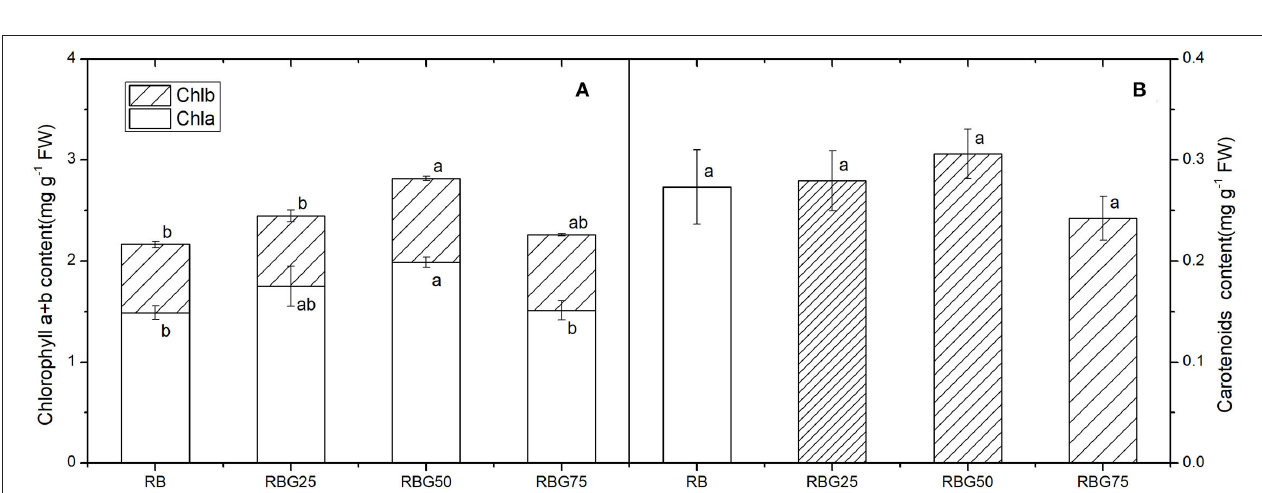
FIGURE 5 | Effect of different spectral conditions on chlorophyll content of cucumber leaves after 9 days drought stress. (A) Chlorophyll a and chlorophyll b content of cucumber leaves. (B) Carotenoids content of cucumber leaves. RB, RBG25, RBG50 and RBG75 are the different spectral conditions, respectively. The PPFD for all the treatments was 250 µ mol m − 2 s − 1 . The data presented were the means ± SE ( n = 3). Different lowercase letters on the bar chart indicated significant differences among treatments according to Tukey’s test ( p < 0.05).